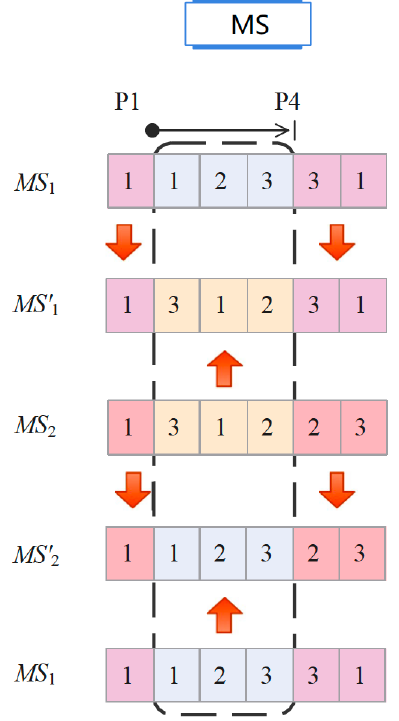
Figure 5. A two-point crossover